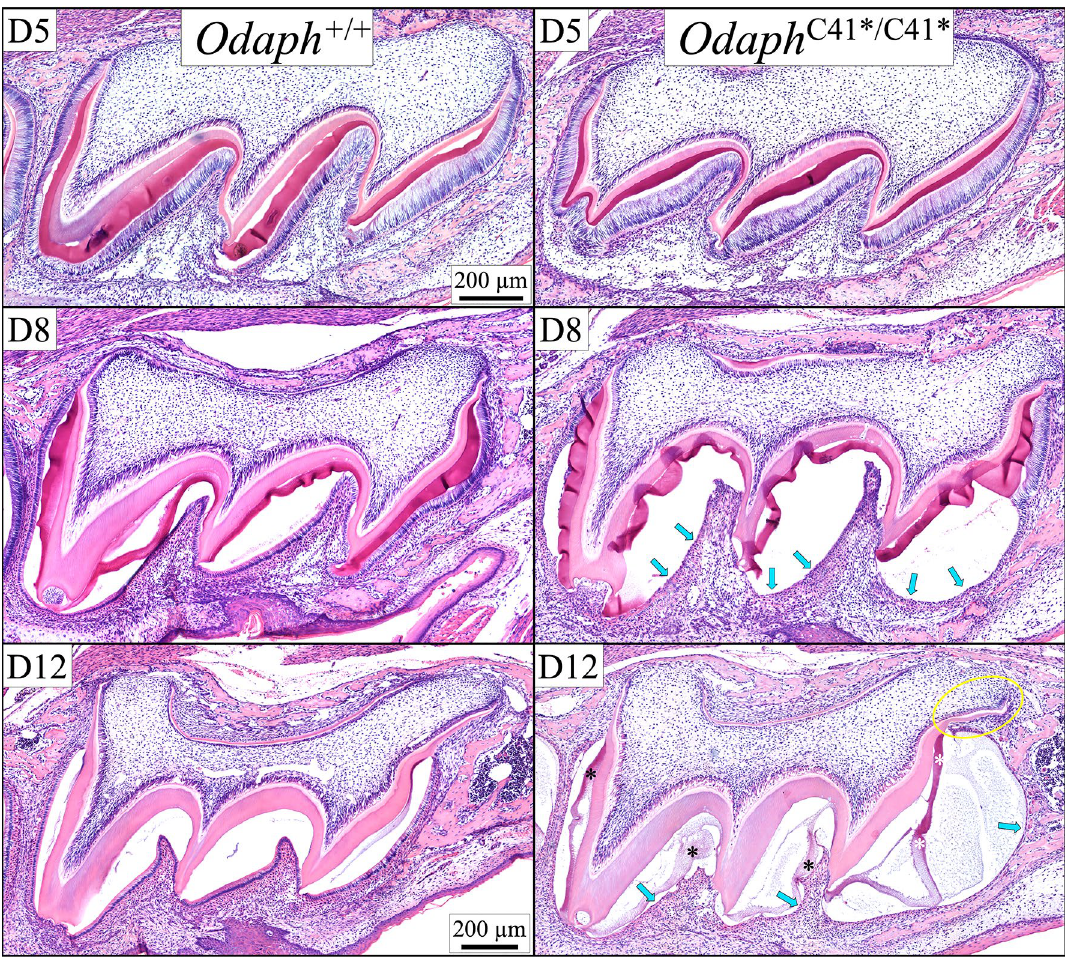
Figure 4. Odaph +/+ and Odaph C41*/C41* Maxillary First Molar Histology at D5, D8 and D12. Day 5 first molar ameloblasts have not yet entered the maturation stage. The histology appearances of Odaph +/+ and Odaph C41*/C41* secretory stage ameloblasts in D5 molars were similar to each other and the degree of enamel and dentin matrix deposition was comparable. Day 8 wild-type first molar ameloblasts are predominantly in the maturation stage. The maturation stage ameloblasts in D8 Odaph C41*/C41* molars were flattened along the cuspal slopes (arrows) and the enamel space was expanded, due to apparent cyst formation. Dentin and root development appeared to be normal. On Day 12 molars, polarized late-maturation stage ameloblasts covered the Odaph +/+ molars, whereas only flattened epithelial cells (arrows) covered the same area in the Odaph C41*/C41* molars, and residual enamel matrix (*) was still apparent in the enamel space. Mesial root development was distorted (yellow circle) presumably due to the expanding cystic space at the cervical margin. Dentin, root development, and alveolar bone appeared to be